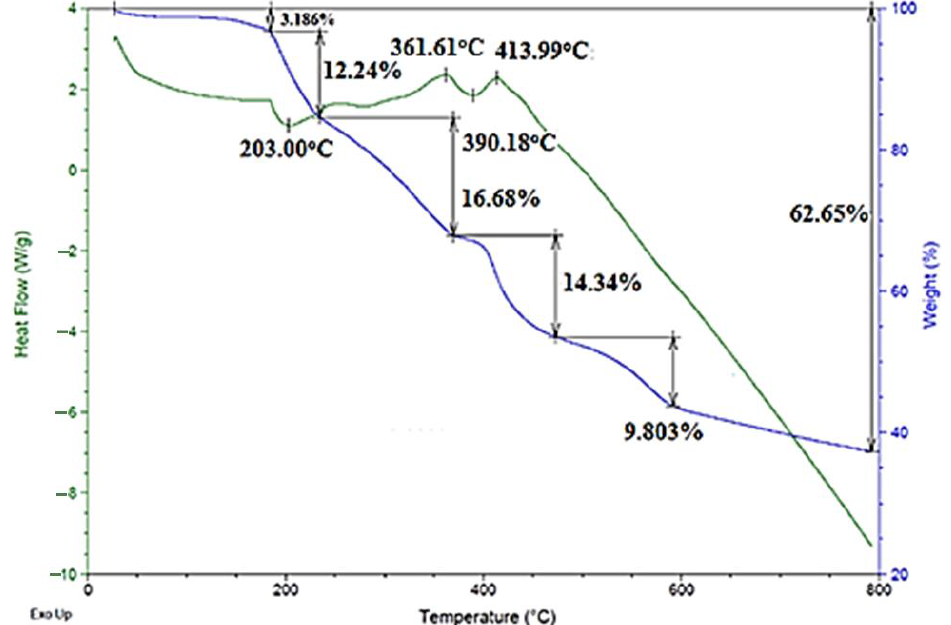
Figure 5. Thermogram of 3